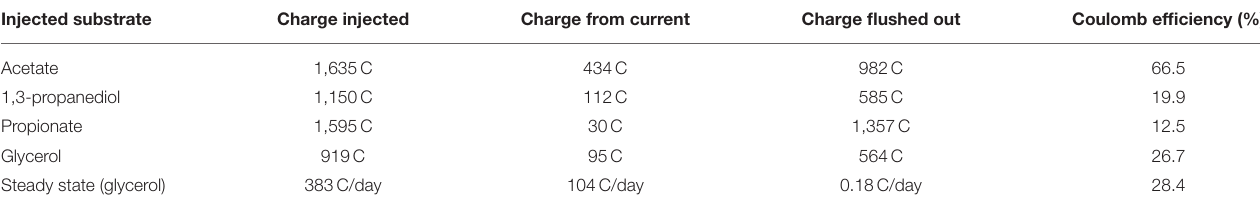
TABLE 1 | Coulomb efficiencies for all concentration pulse responses and steady state glycerol operation. Injected substrate